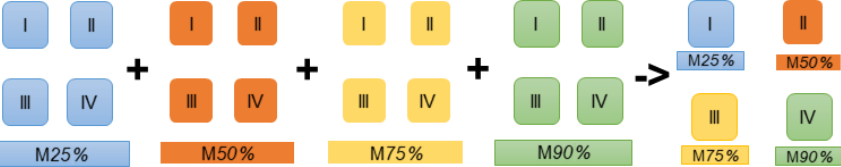
Figure 5. An example of a multi-model combination in which the four building classes I, II, III and IV are assigned to the 2D HD model results of 25%, 50%, 75% and 90% respectively.